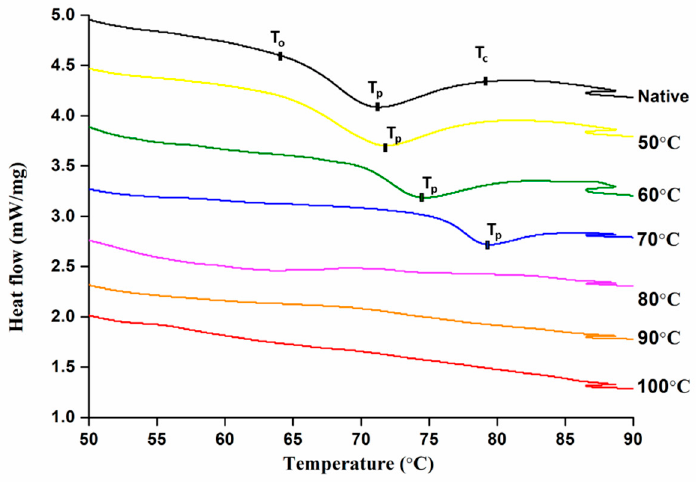
Figure 1. Thermal properties of controlled gelatinized mung bean starch.